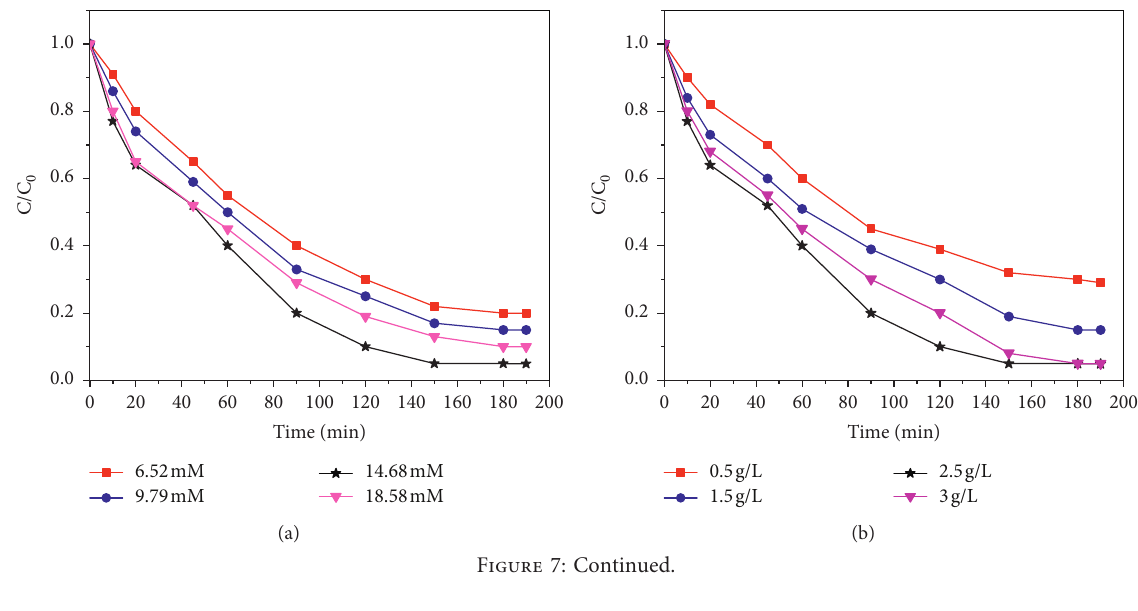
Figure 6: Degradation of MB in different operation systems. Reaction conditions: [MB] � 50 mg/L, [H [catalyst] � 2.5 g/L under natural